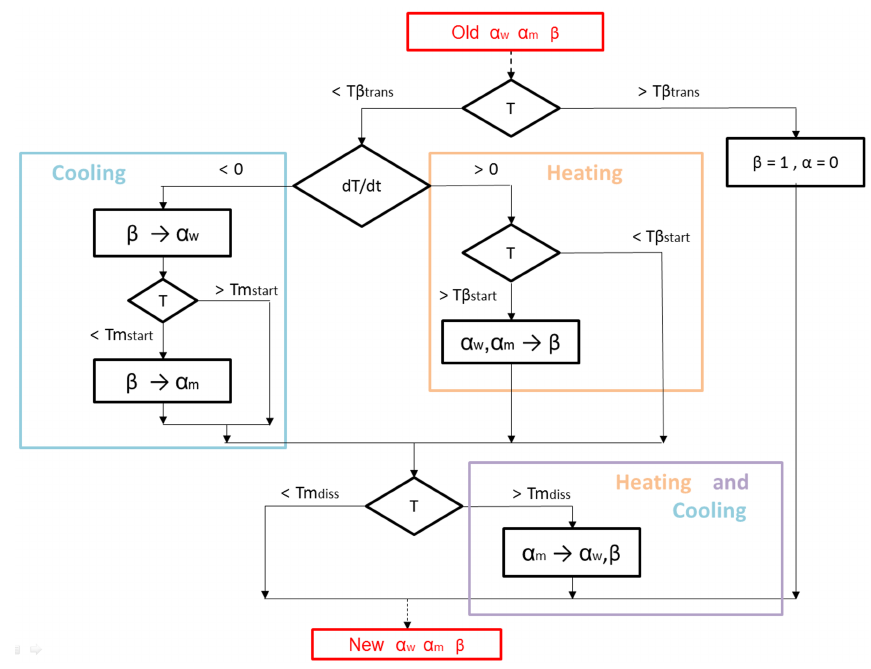
Figure 4: Flowchart for microstructure model implementation. Figure 4. Flowchart for microstructure model